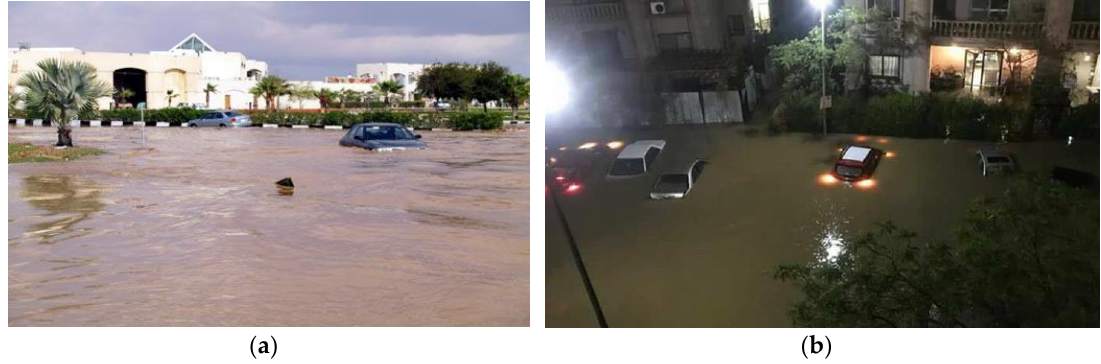
Figure 3. The disaster impacts of the flash floods in Al-Arish city in 2010 [52] ( a ), and urban floods at new Cairo City 2018 [53] ( b new Cairo City 2018 [53] ( b ).